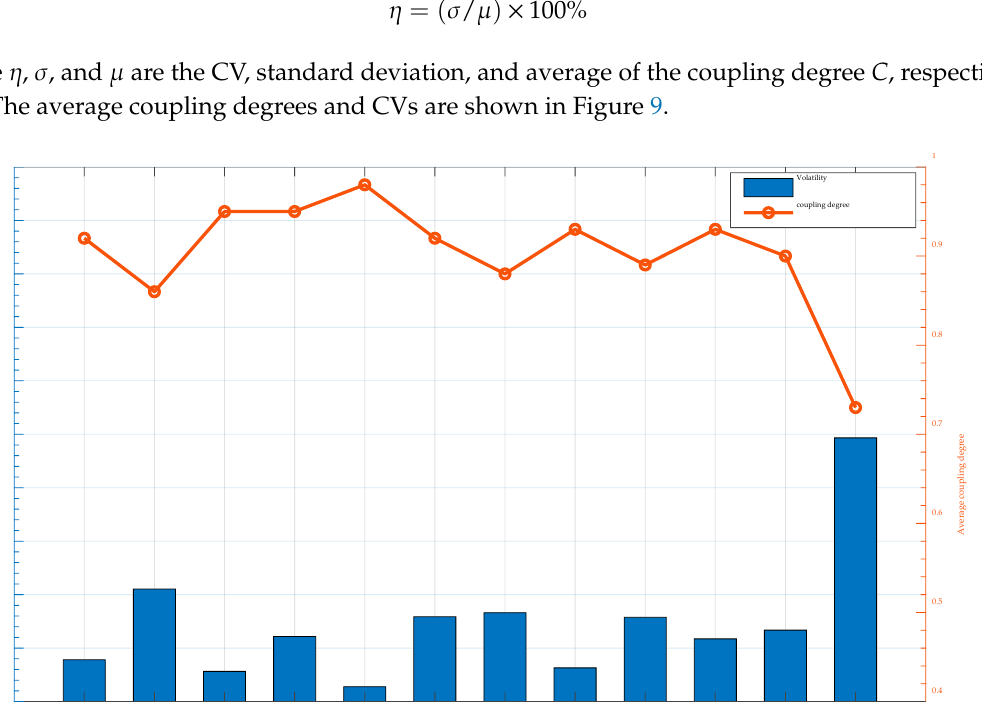
Figure 9. Average coupling degree and CV of the coupling systems. Note: V1: AR–MR, V2: AR–SR,